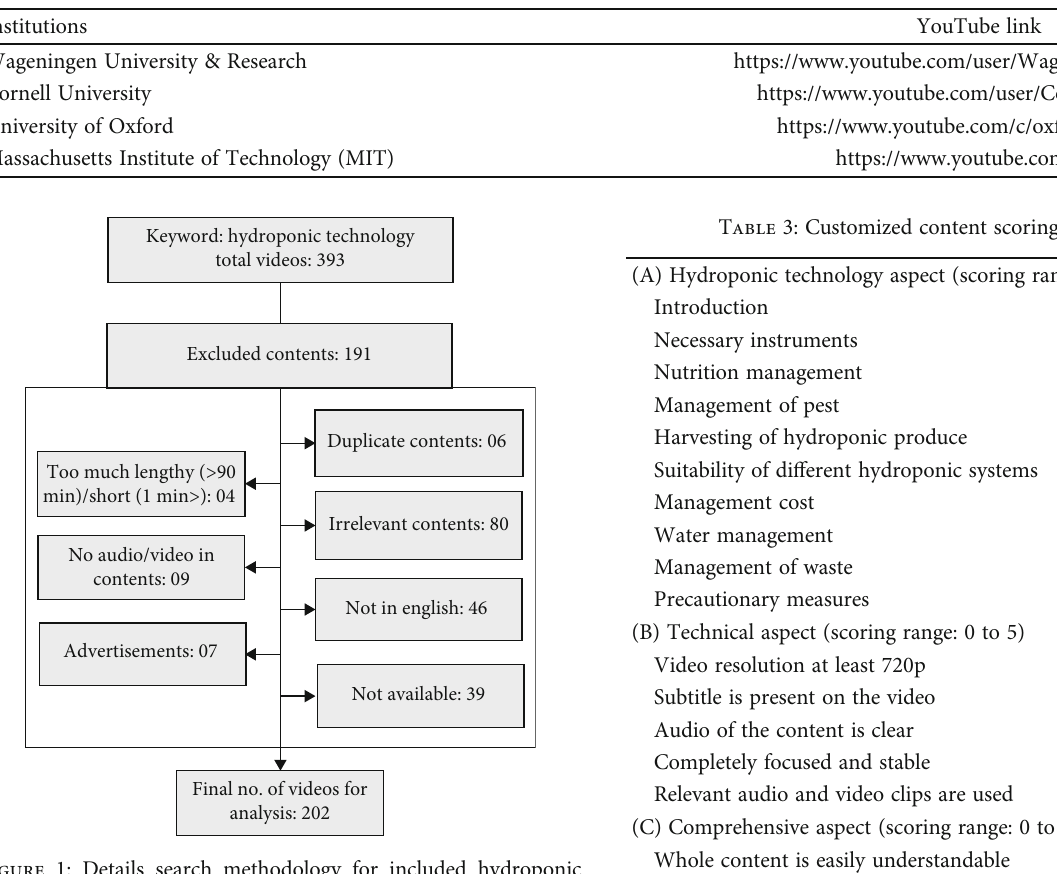
Table 2: YouTube Channel of di ff erent educational institutions.